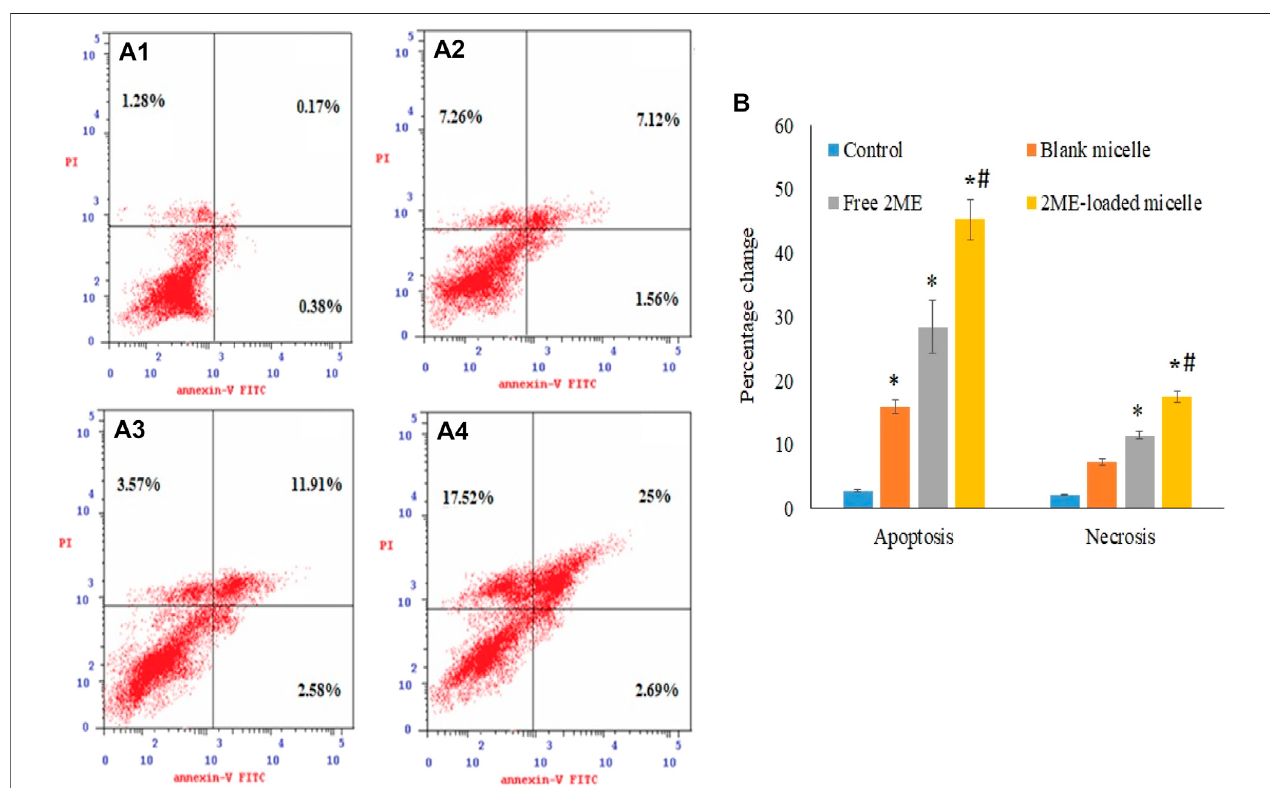
FIGURE5| Apoptoticandnecroticassessmentofblank-micelles,free2ME,and2ME-loaded micellesinPC-3cellline.Thecellswereexposedtothesamplesfor 24 h and stained with Annexin-V/FITC and propidium iodide, control (A) (i) , blank micelles (ii) , free 2 ME (iii) , and 2 ME-loaded micelles (iv) . (B) Representation of PC-3 cell death following apoptotic and necrotic assay by cytometric analysis after annexin V staining. Values are expressed as mean ± SD ( n (cid:2) 3). * represents signi fi cant difference from control group ( p < 0.05). # represents signi fi cant difference between 2 ME-loaded micelles vs other groups.